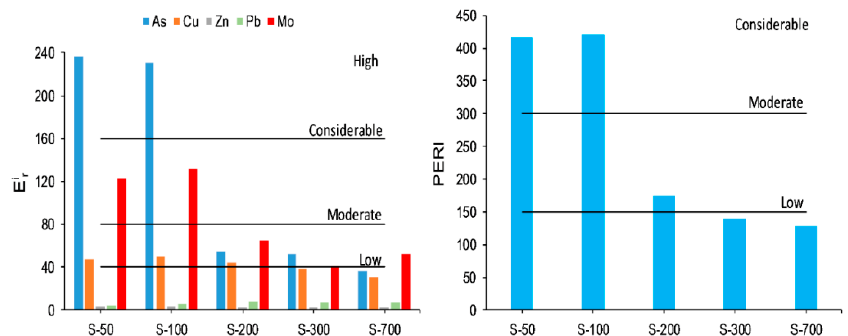
Figure 3. Potential ecological risk index of single (E i r ) and total (PERI) HMs in the soil located at different distances from the Alaverdi copper smelter.